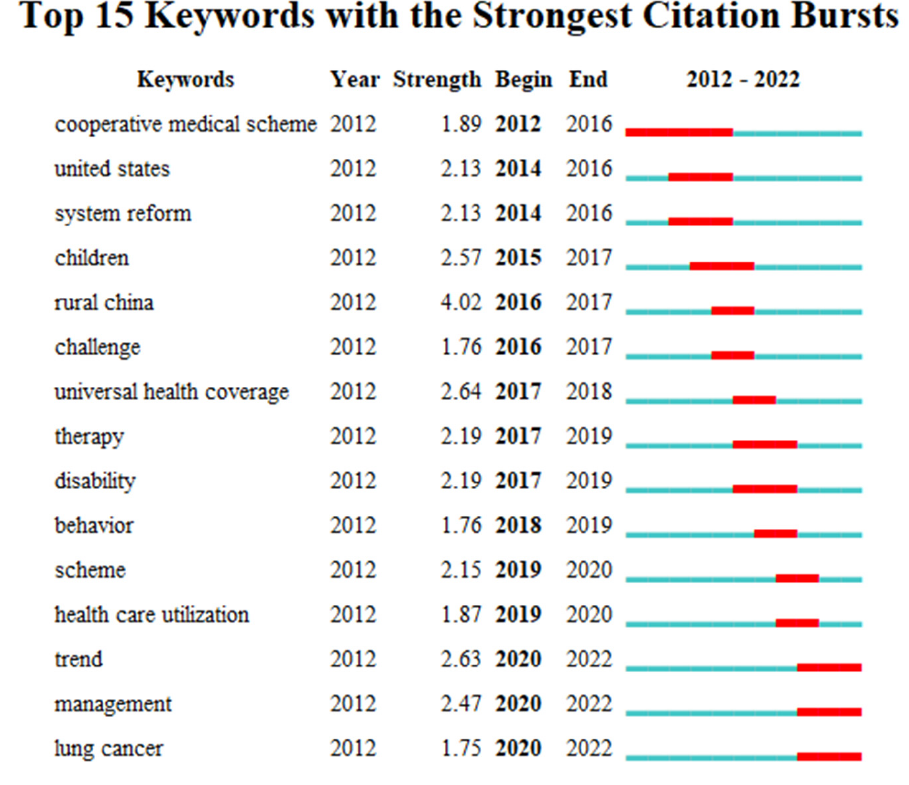
Figure 3. Top 15 keywords with the strongest citation burst, related to basic health insurance.